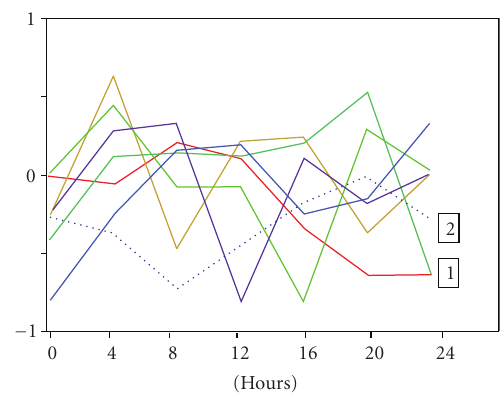
Figure 3: PCA of HBMEC profiles after C. neoformans infection; microarray data were analyzed by the GeneSpring software to clas- sify the gene expression patterns. Seven major gene profiles were ob- tained as shown in di ff erent color. The major groups (PCA groups no.1 and no.2) are indicated in the graph, which contain more than 50% of total analyzed